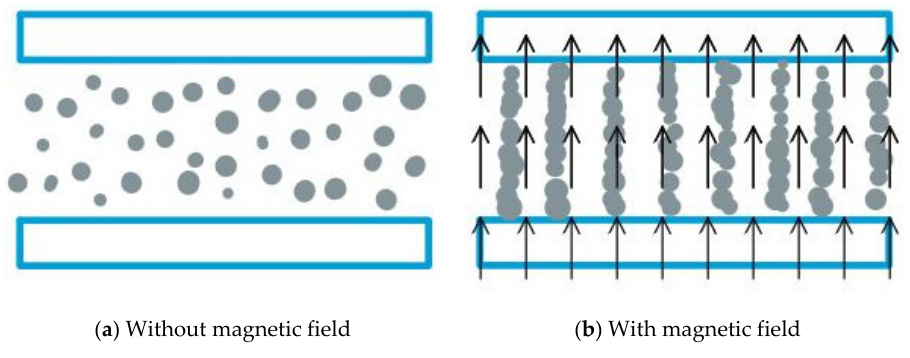
Figure 1. Working principle of MR fluid.